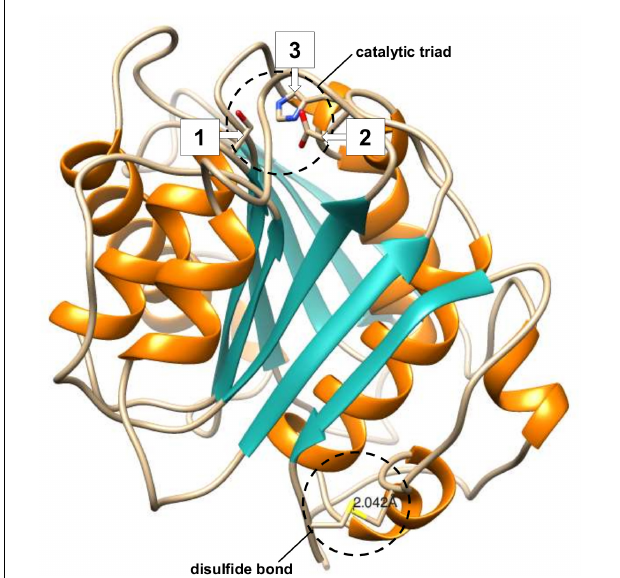
FIGURE 3 | Three-dimensional structure of BgP based on the SeL (PDB code: 1JFR) template from Streptomyces exfoliatus , generated using UCSF-Chimera. Catalytic residues and disulfide bond cysteines are shown in stick form and circled. The calculated distance between the sulfur atoms of each cysteine is displayed in angstroms (Å). Secondary structures are shown as teal strands and orange helices, while coils are left uncolored.